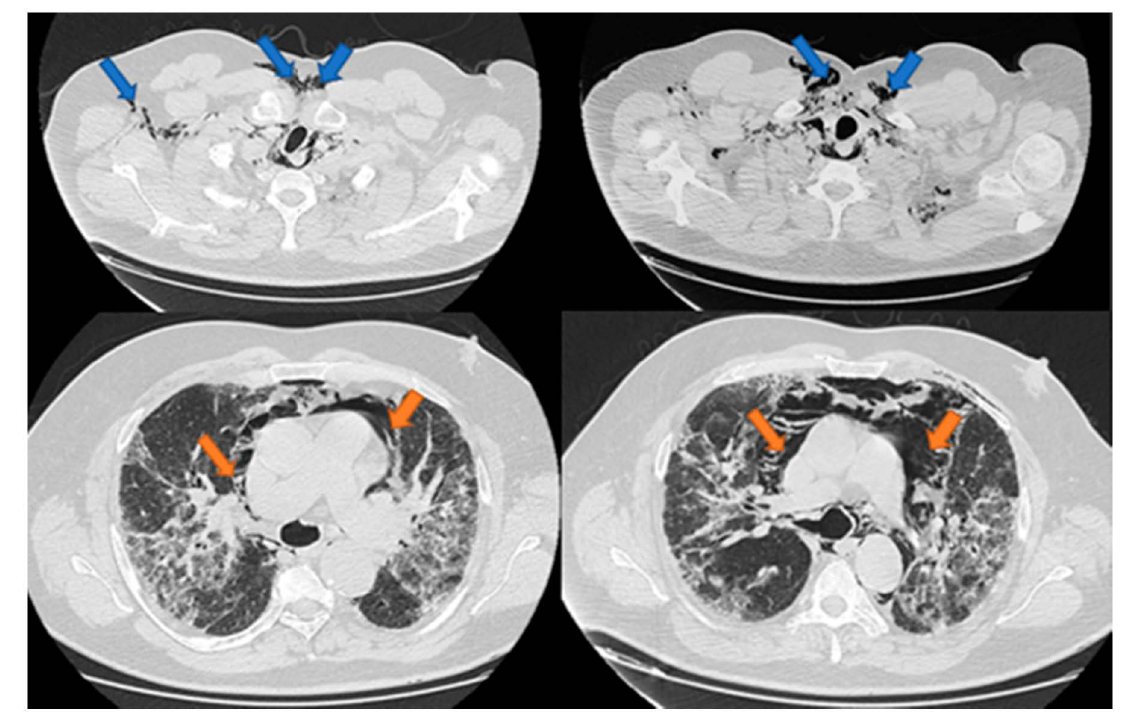
Figure 2. Case 2-Pneumomediastinum and subcutaneous emphysema. Legend: PM—pneumomediastinum—orange arrow; SE—subcutaneous emphysema—blue arrow.